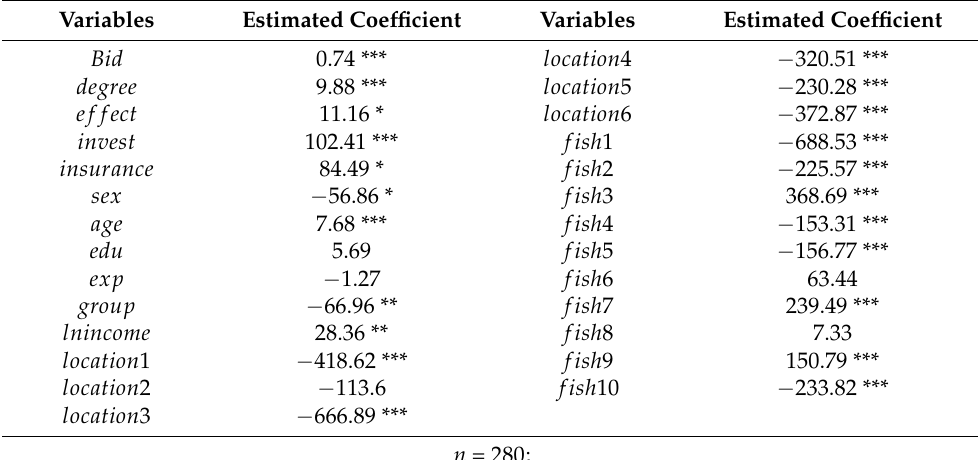
Table 5. Empirical results for the aquaculture farmers’ bidding